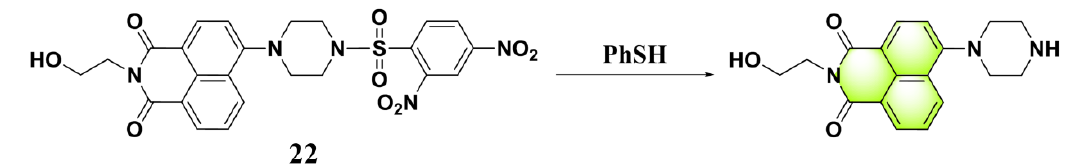
Figure 9. Structure and reaction of probe 22 with PhSH.